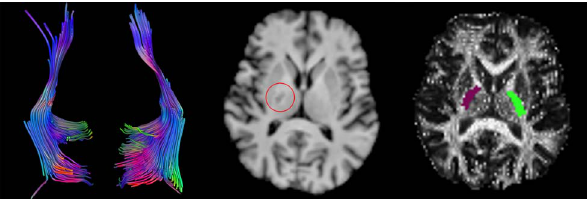
Figure 4. Diffusion tensor tractography in a stroke patient. The results of diffusion tensor tractography (left) in a patient who experienced subcortical stroke, causing relevant unilateral hand motor impairment. The lesion in the left posterior limb of the internal capsule is marked by a red circle on a T1-weighted anatomical slice image (middle), the de-normalized ROIs are shown as colored overlays on an FA slice image (right).